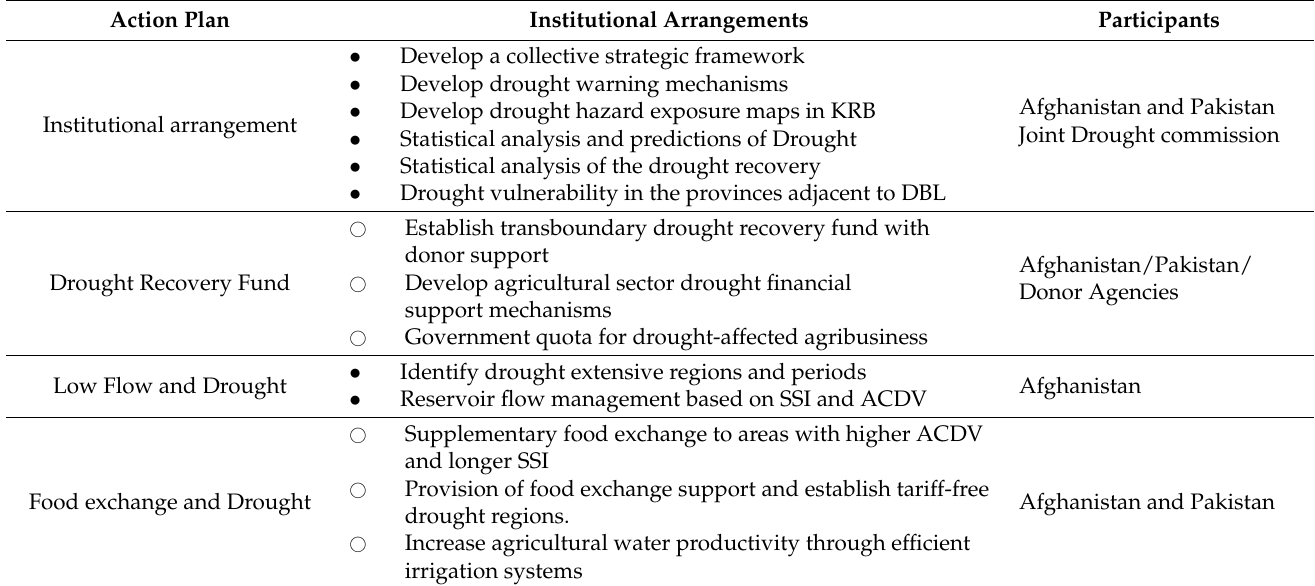
Table 9. Proposed Joint Drought Commission Action Plan